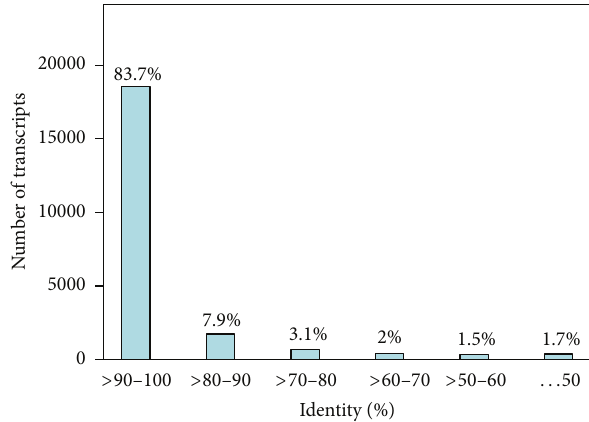
Figure 2: Sequence identity distribution. All BLASTX-hit tran- scripts were calculated. Vertical light blue bar shows the number of transcripts-derived contigs with which the range of percentage hit by